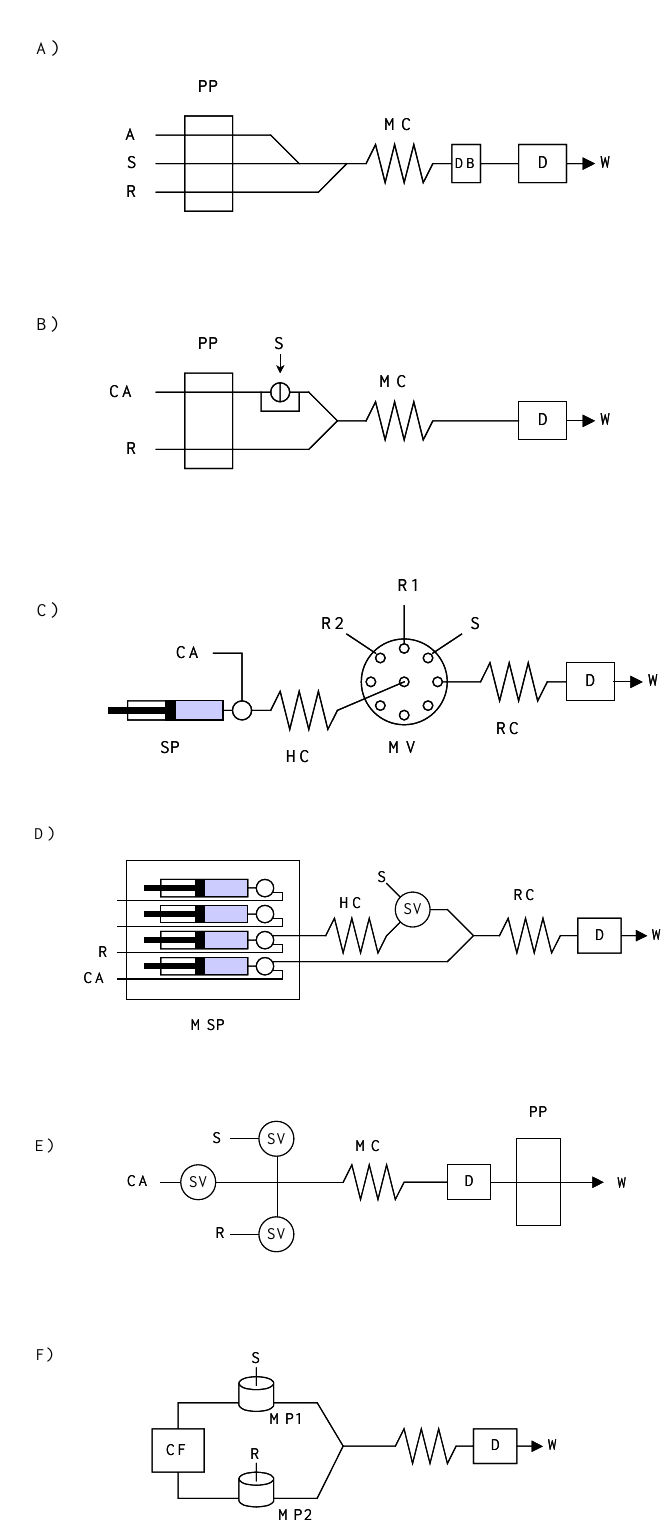
Figure 1. Schematic diagram of flow system: A) Segmented flow analysis (SFA), B) Flow injection analysis (FIA), C) Sequential injection analysis (SIA), D) Multisyringe flow analysis (MSFIA), E) Multipumped flow injection analysis (MPFIA), and F) Multicommutated flow injection analysis (MCFIA): PP = peristaltic pump; A = Air; S = Sample; R = Reagent; MC = Mixing Coil; DB = Debubbler; D = Detector; W = Waste; CA = Carrier; SP = Syringe Pump; HC = Holding Coil; MV = Multi-Ports Valve; RC = Reaction Coil; MSP = Multisyringe Pump; SV = Solenoid Valve; CF = Control Interface; MP = Micro